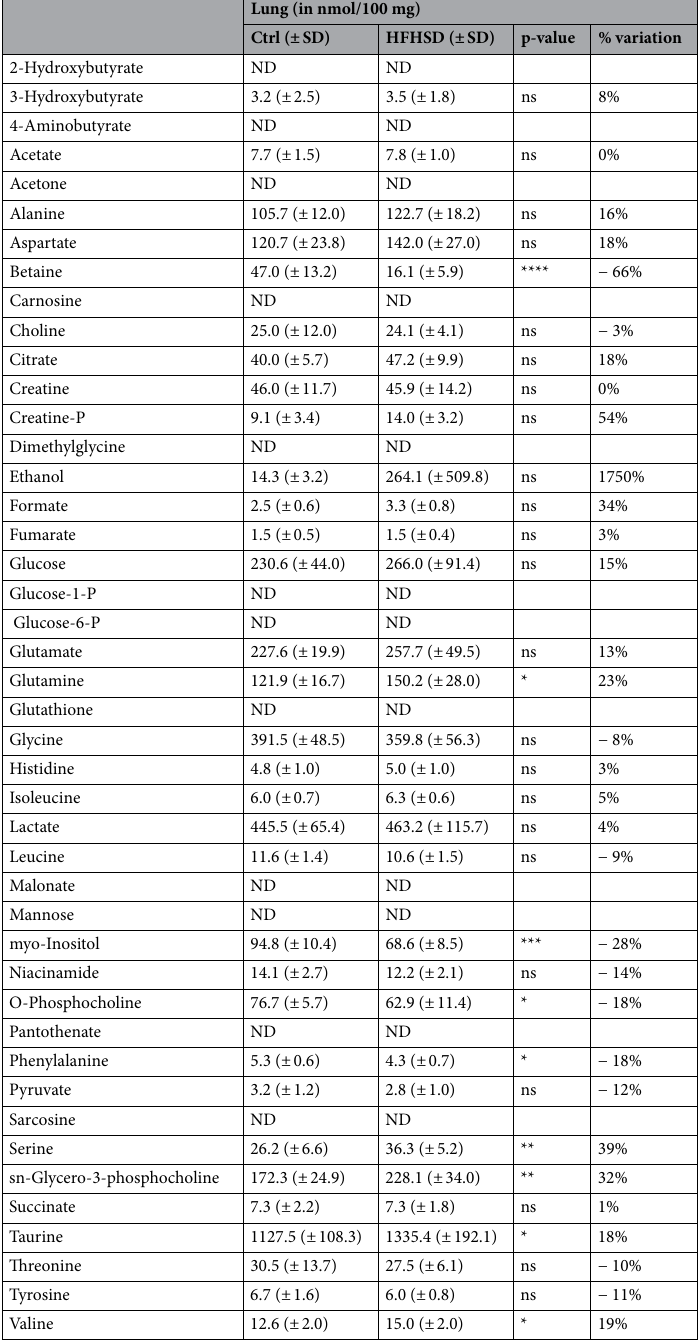
Table 2. Metabolite concentrations measured by NMR in the lung of SD and HFHSD mice. Results are expressed as mean ± standard deviation (SD) and are in nmol/100 mg of lung. Data are mean of n = 8 mice per group; Results of unpaired two-tailed t-test are indicated as non-determined (ND), non-significant (NS), p < 0.05 (*), p < 0.01 (**), p < 0.001 (***) and p < 0.0001 (****). Percentages of variation between HFHSD and control fed mice are